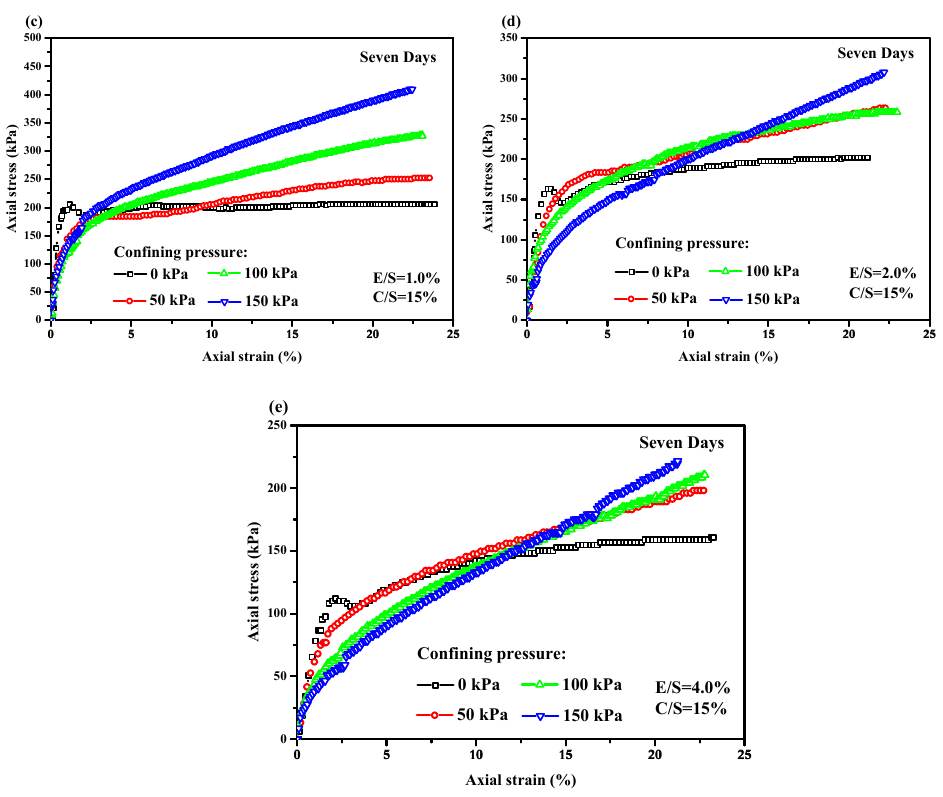
Figure 8. Axial stress and axial strain curves of EPS-cement lightweight clay with different confining pressures for seven days curing period with cement ratio 15% for all EPS ratios ( a ) 0%; ( b ) 0.5%; ( c ) 1.0%; ( d ) 2.0% and ( e ) 4.0%.